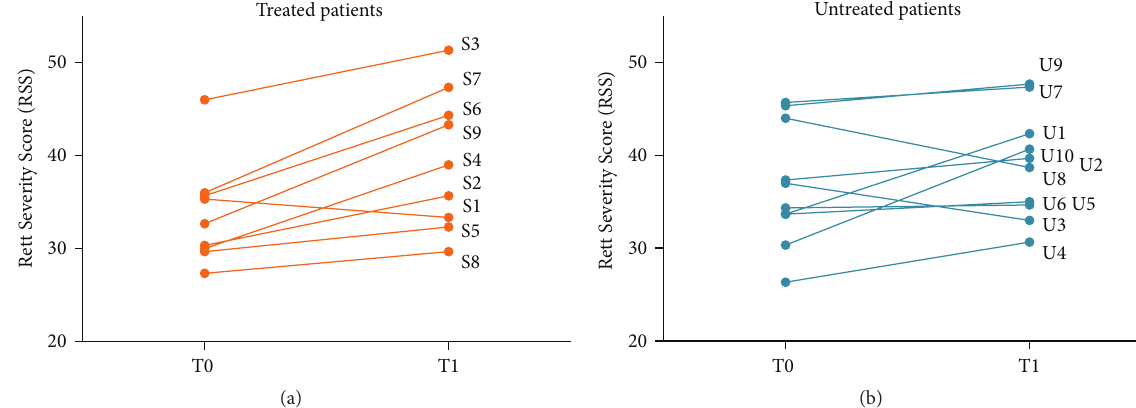
Figure 2: Combined features of social and cognitive scores before and after treatment for IGF1 treated patients in comparison to untreated patients. The change in Rett Severity Score (RSS) was significant for RSS 1–3 ( 𝑝 = 0.0078 ) as analysed by Wilcoxon Matched-Pairs Signed Ranks Test. A higher score correlates to better social/cognitive